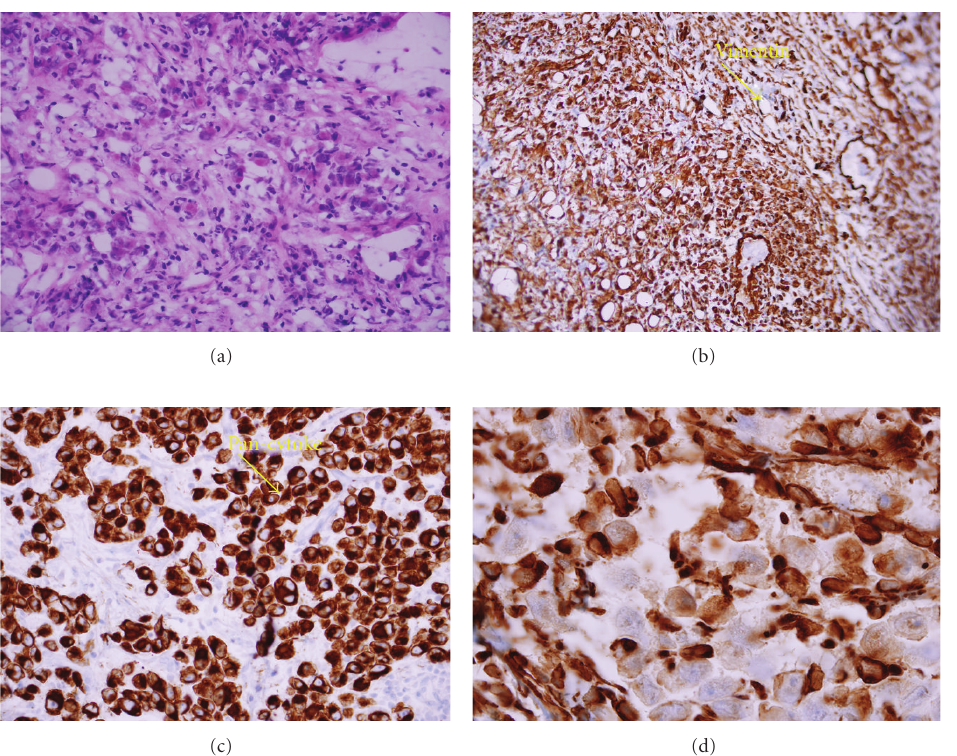
Figure 2: (a) Tumor cells with a cytoplasmic pink ball pushing the nucleus, (b) Pan Cytokeratin positivity, (c) Vimentin positivity, (d) Pan Cytokeratin high-power